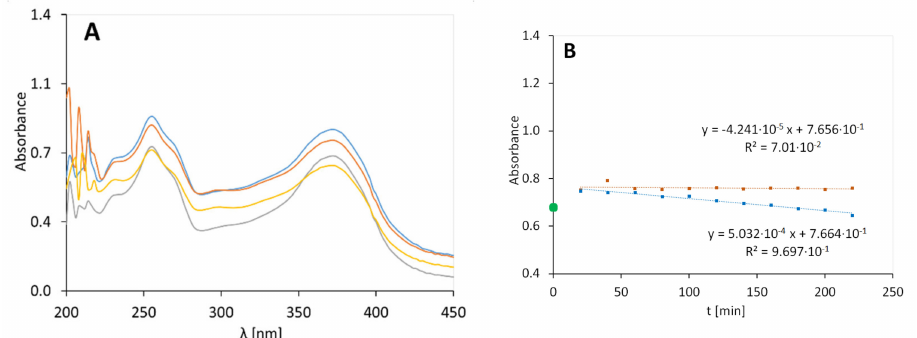
Figure 3. UV-Vis spectra of the PAA gel with quercetin (preparation 2B), irradiated at 0 ( - ), 80 ( - ), 120 ( - ), and 200 ( - ) minutes ( A ). The graph on the right ( B ) shows the UV degradation of a gel containing PAA and quercetin (orange dots are used for the results of unexposed samples and blue dots are used for the result obtained for the irradiated